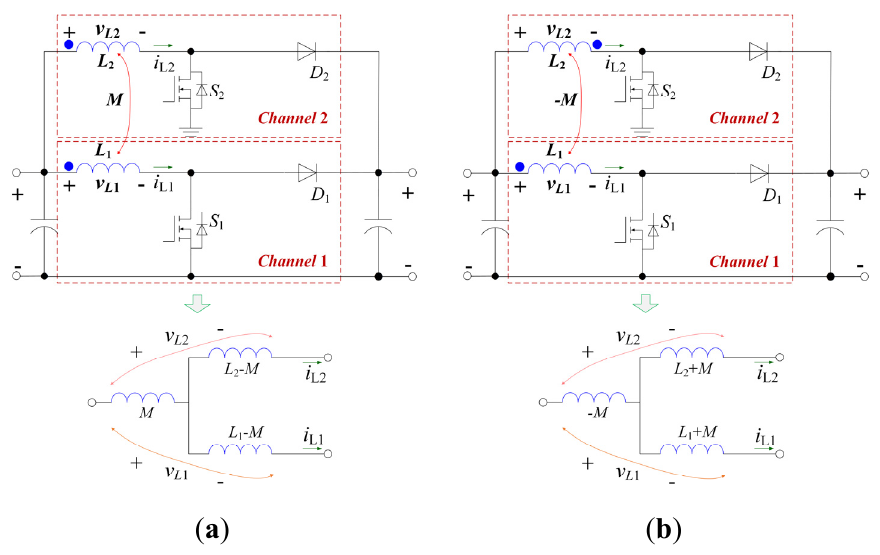
Figure 5. Two different coupling patterns ( a ) Direct coupling; ( b ) Inverse coupling.